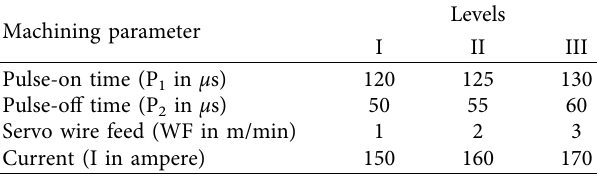
Table 4: Machining parameters and fixed